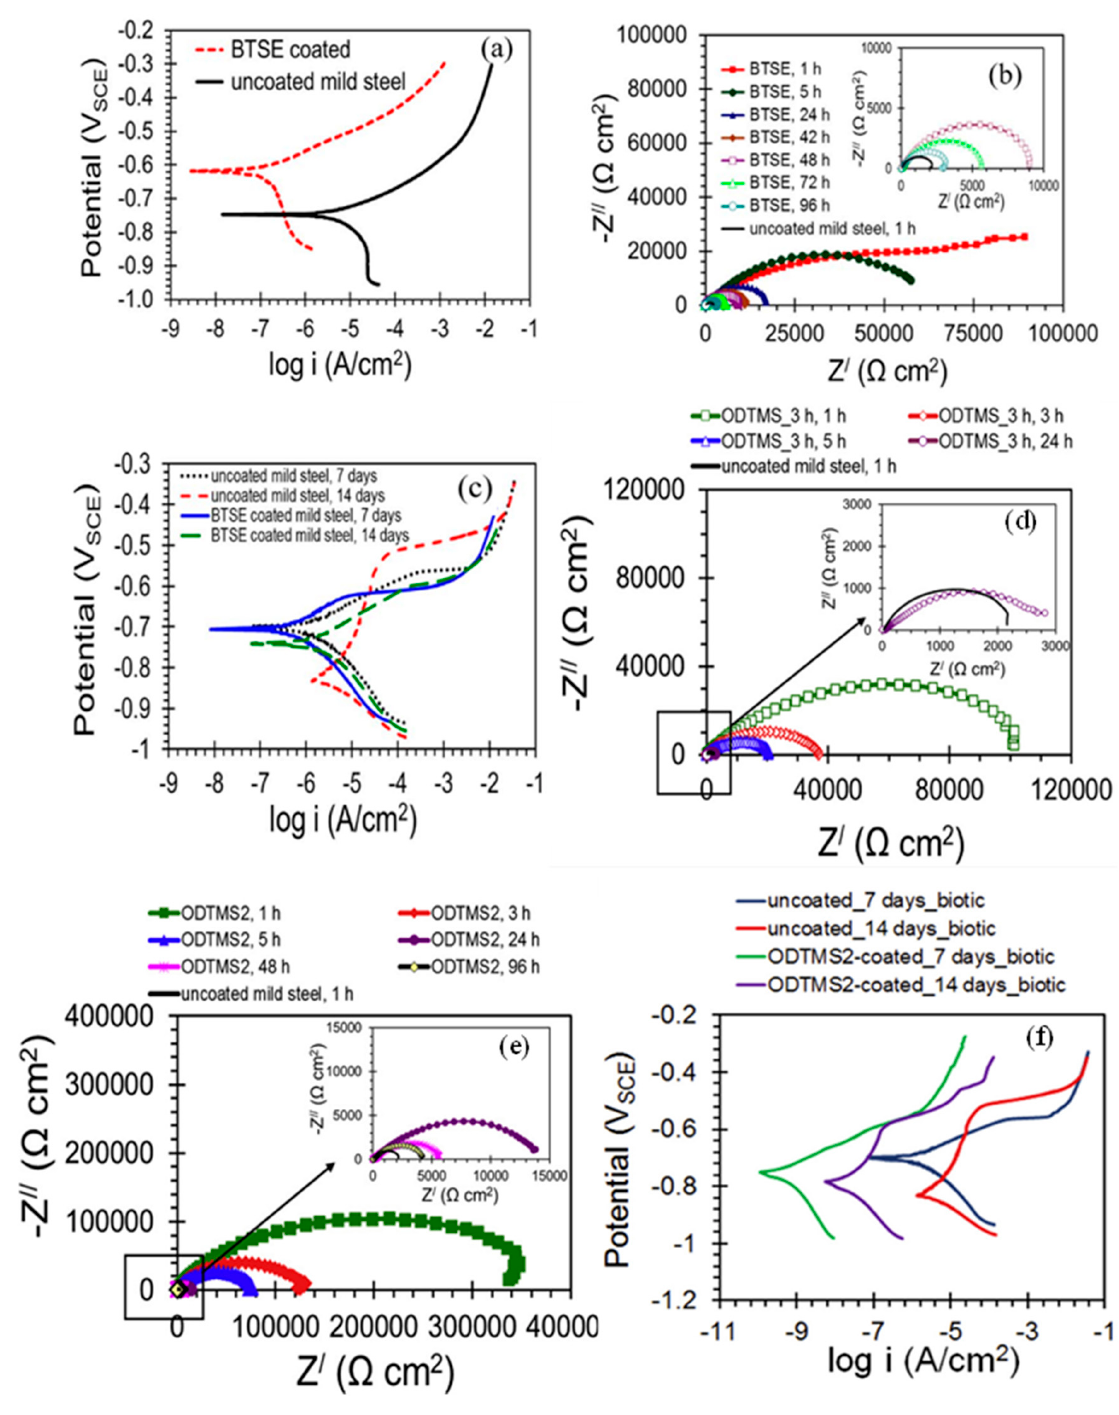
Figure 12. ( a ) PDP plots of the BTSE-coated and uncoated mild steel pre-immersed for 1 h in 0.6 M NaCl solution, ( b ) Nyquist plots for the BTSE-coated specimens at different durations of immersion and the uncoated mild steel specimens at 1 h of immersion in 0.6 M NaCl, ( c ) PDP plots of the BTSE-coated and uncoated specimens after different exposure times in the marine environment with SRB [95], ( d ) Nyquist plots for uncoated and ODTMS-coated mild steel pre-immersed in 3.5% NaCl solution for 1, 3, 5 and 24 h, ( e ) Nyquist plots for the two-step coated (ODTMS2) and uncoated mild steel pre-immersed in 3.5% NaCl solution up to 96 h and ( f ) PDP curves of ODTMS2-coated and uncoated mild steel specimens after exposures for 7 and 14 days to marine environment inoculated with SRB [96].